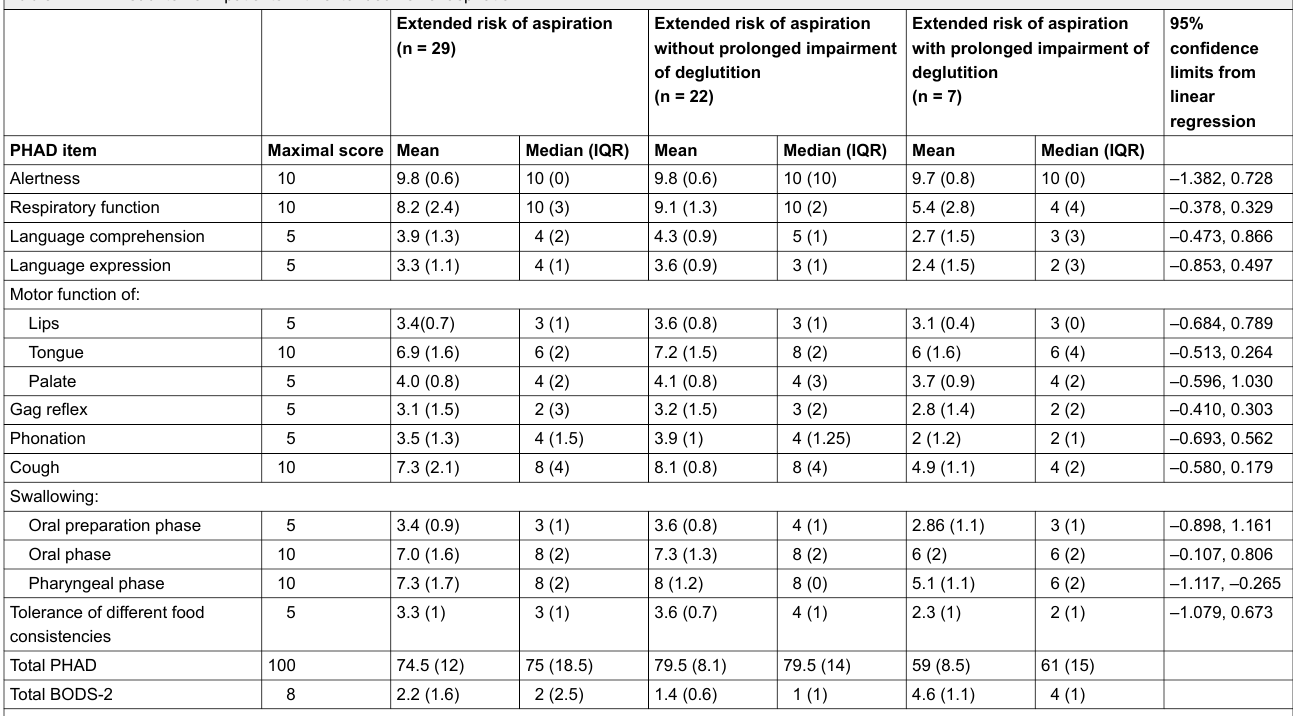
Table 2: PHAD sub-items in patients with extended risk of